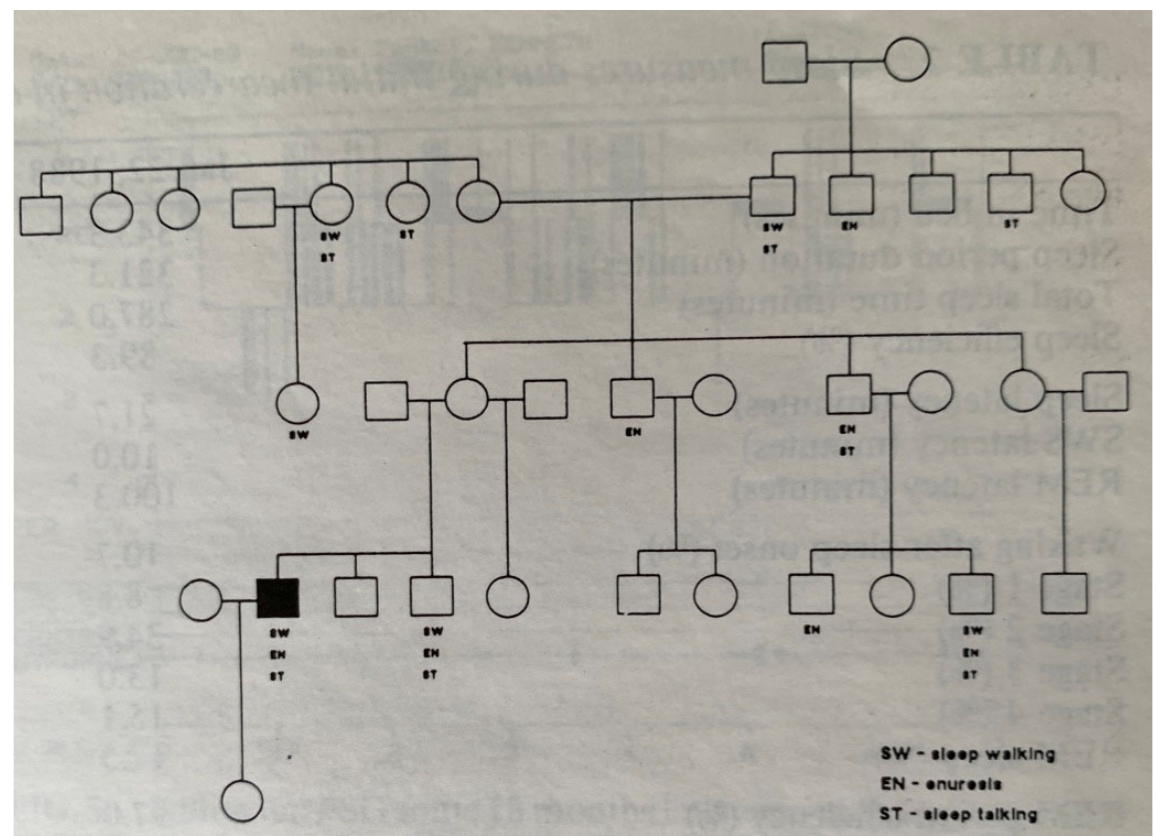
Figure 16. This diagram shows the family tree of Ken Parks. Males are in squares and female are in circles. The black square is Ken Parks. It is notable that in his extended family there are many cases of enuresis nocturn, sleepwalking and sleep talking. Such a family pattern is present in many patients with enuresis, sleepwalking, sleep terrors or confusional arousals. (Reproduced with permission from Broughton R, Billings R, Cartwright Ret al. Homicidal Somnambulism: A Case Report. Sleep, Volume 17, Issue 3, May 1994, Pages 253–264, https://doi.org/10.1093/sleep/17.3.253, published by Oxford University Press)